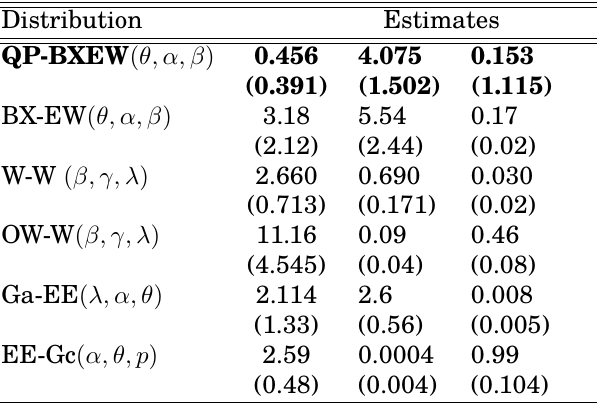
Table 6: MLEs and SEs for survival times data. Distribution